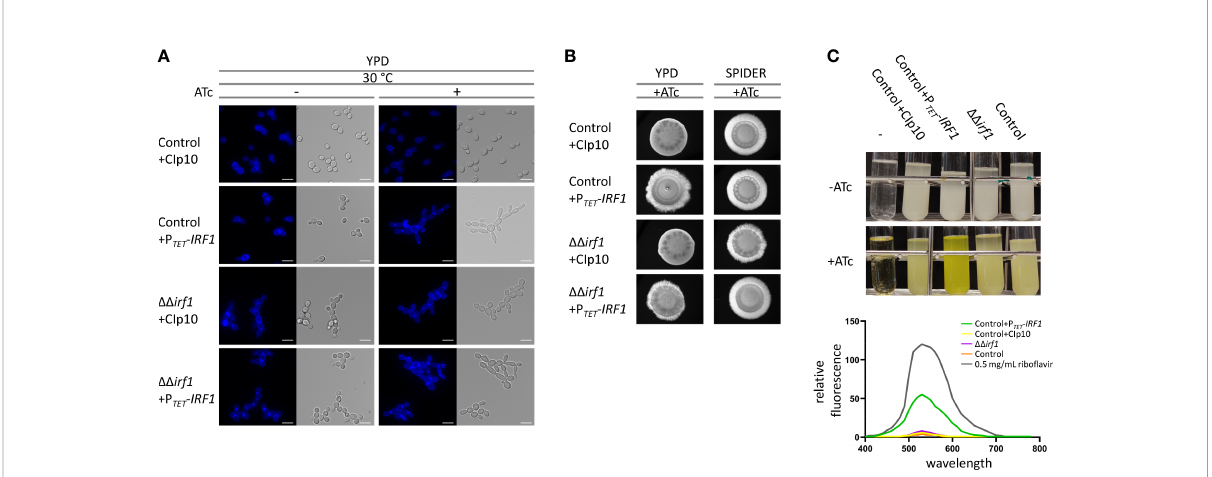
FIGURE 1 Overexpression of IRF1 induces fi lamentation and the production of ribo fl avin. (A) C. albicans control strain harbouring either the empty CIp10 plasmid or the P TET - IRF1 plasmid and the irf1 knockout strain harbouring either the control CIp10 plasmid or the P TET - IRF1 plasmid were grown in YPD medium at 30°C to logarithmic phase either in the presence or absence of anhydrotetracycline (ATc). Calco fl uor-white was used for staining chitin in the cell wall. Scale bars = 3 m m. (B) Colony morphology of indicated C . albicans strains grown on YPD or SPIDER medium supplemented with anhydrotetracycline (ATc). Microphotographs were taken after 3 days of incubation at 37°C. (C) C. albicans control strain harbouring either the empty CIp10 plasmid or the P TET - IRF1 plasmid and the irf1 knockout strain and its parental strain (control) were grown in LoFlo glu medium supplemented or not with anhydrotetracycline. Top: culture after 72h growth; -: blank. Bottom: supernatants of indicated strains were cleared and the fl uorescence spectra were measured upon excitation at 450 nm. Data are expressed as fl uorescence relative to OD 600 of the cultures as average and SEM. As a control the spectrum of 0.5 mg/mL ribo fl avin was